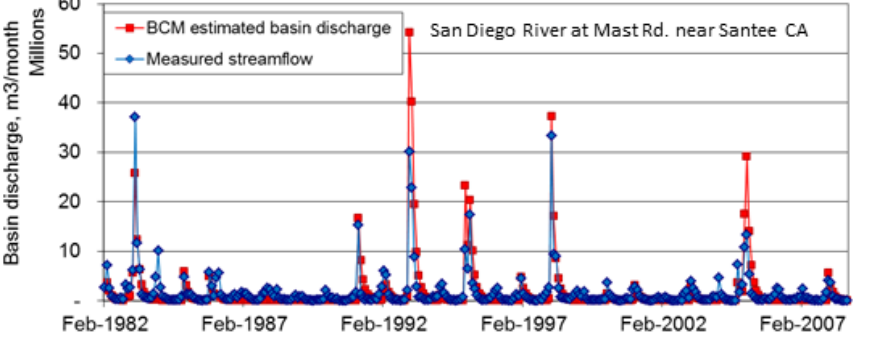
Fig. 8. Comparison of measured streamflow at Mast Road stream gage on the San Diego River with basin discharge estimated using the Basin Characterization